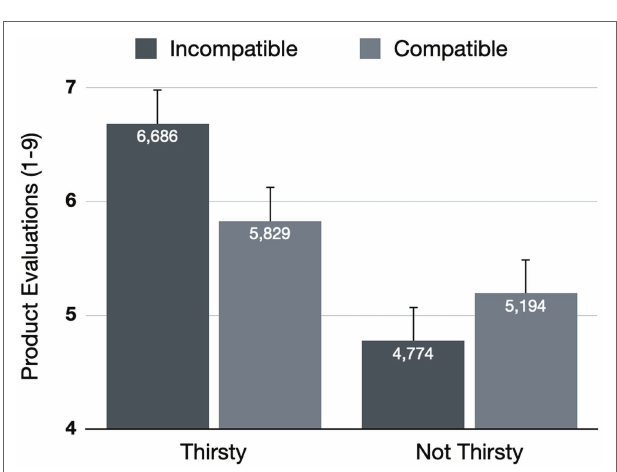
FIGURE 2 | Product evaluations as a function of Stroop compatibility associations and thirstiness. Error bars denote